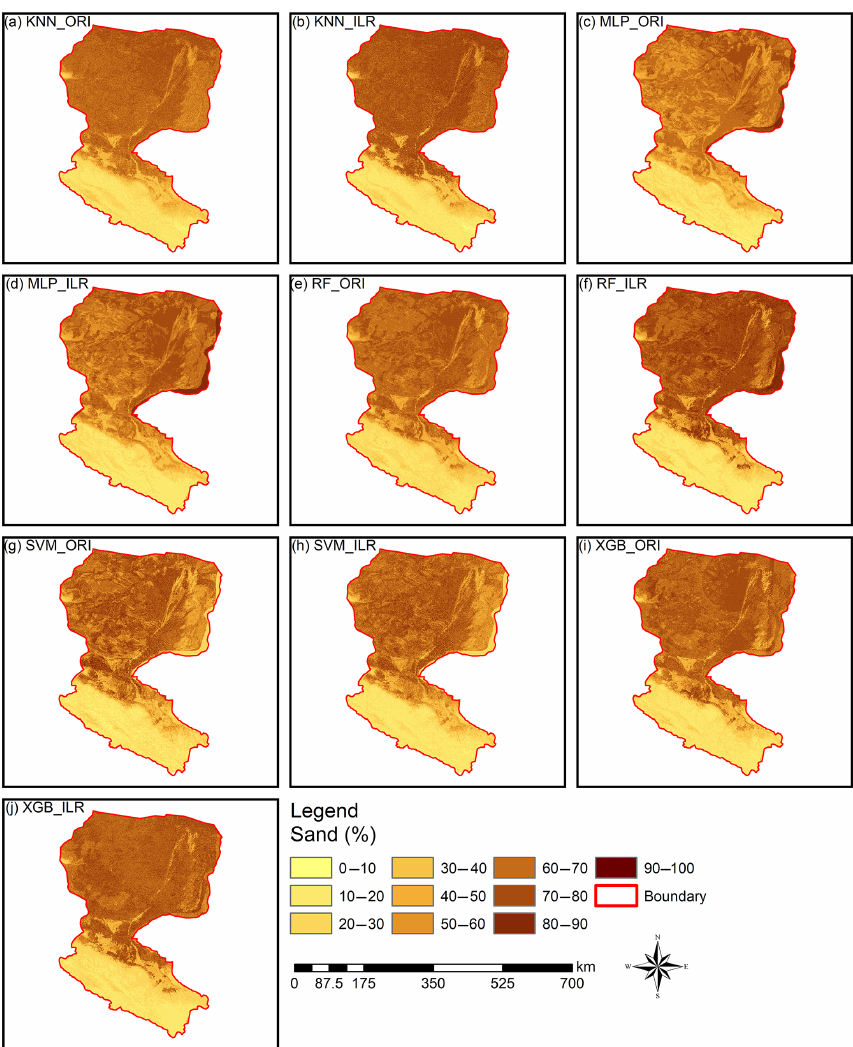
Figure 6. Prediction maps of the sand fraction. All of the ranges of the prediction maps of sand (approximately 9.0%–90.0%) were within the range of the original data (0.98%–99.66%). RF_ILR (7.9%–94.7%) and XGB_ORI (1.8%–92.4%) generated wider output distributions and were relatively closer to the range of the distribution of the original data than other prediction maps, such as KNN_ILR (7.3%–88.6%), KNN_ORI (7.8%–80.8%), MLP_ILR (8.8%–90.8%), MLP_ORI (9.0%–90.3%), RF_ORI (9.0%–81.0%), SVM_ILR (6.5%–85.6%), SVM_ORI (7.3%–90.0%), and XGB_ILR